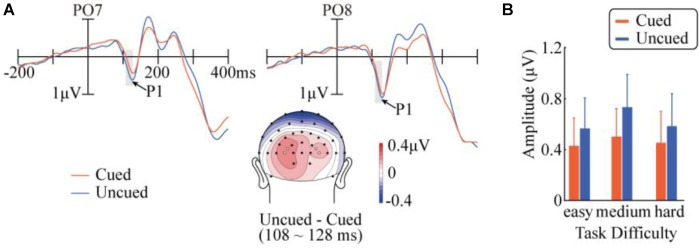
Results in the P1 component. (A) Target-evoked ERP waveforms of cued and uncued conditions at PO7 and PO8, and the topographic map of the difference between cued and uncued conditions. The topographic map was generated with a customized MATLAB function based on EEGLAB’s topoplot function (Delorme and Makeig, 2004), and is available at https://github.com/yangzhangpsy/3dtopoplot. Analyzed electrode locations are marked as white dots in the map. (B) Mean amplitudes across task difficulty and cueing conditions over the four analyzed electrode locations.